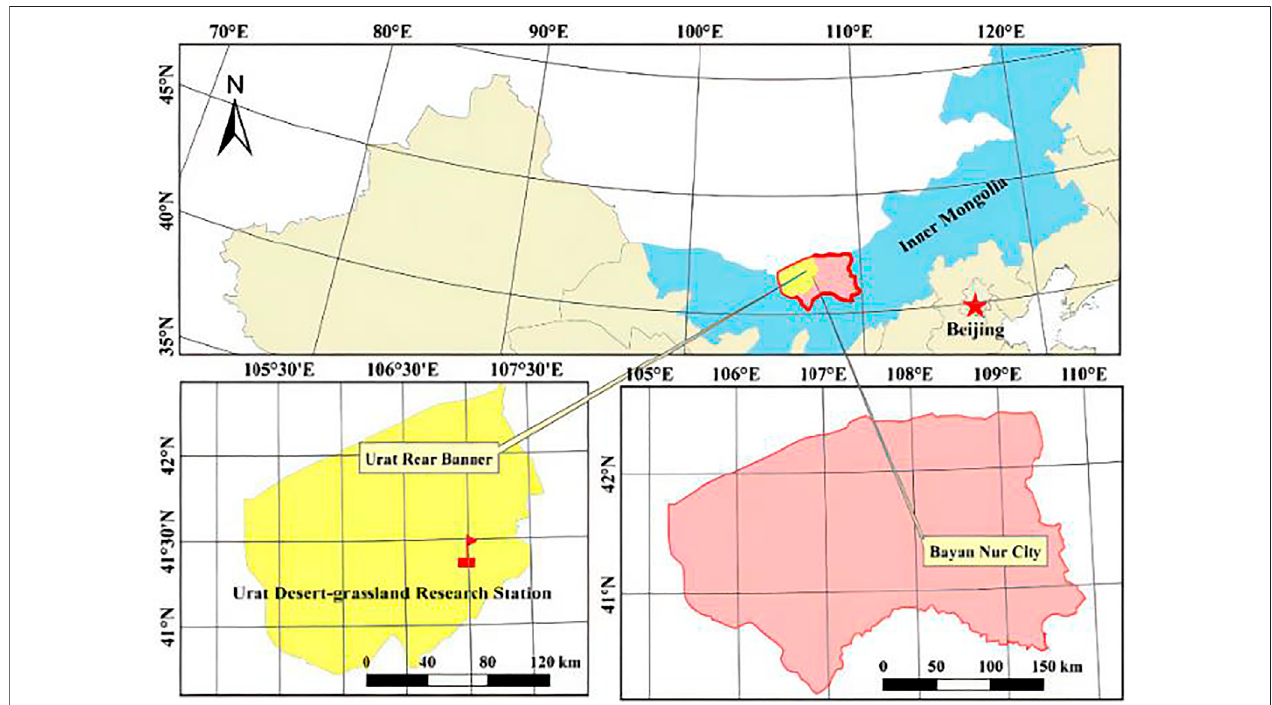
FIGURE 1 | Location and sampling site in Urad desert steppe of Mongolia, northwestern